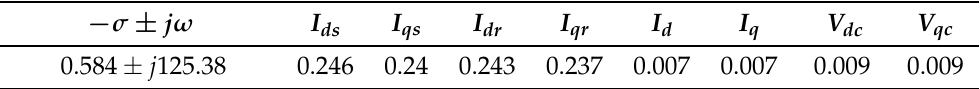
Table 2. Participation factors of critical eigenvalue pair for s g = 1% and 60% series compensation.